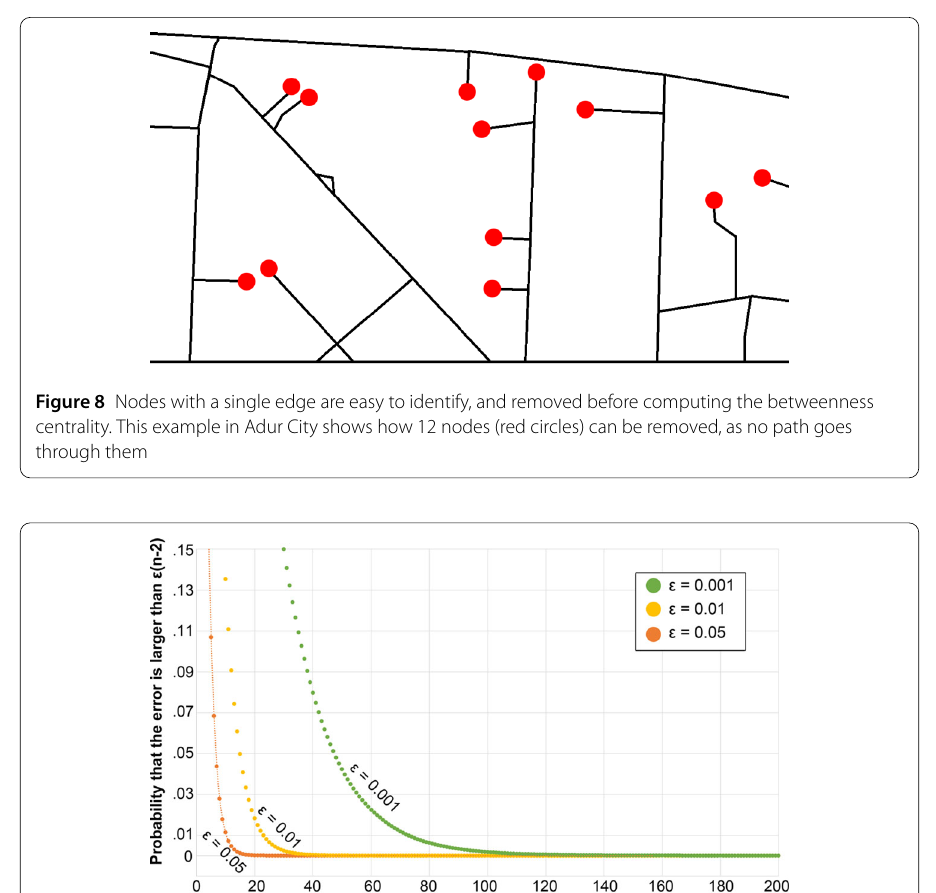
go through them (Fig. 8). Similarly, for closeness, we excluded unreachable nodes (since their distance to others would be infinite and their closeness tend to 0). This